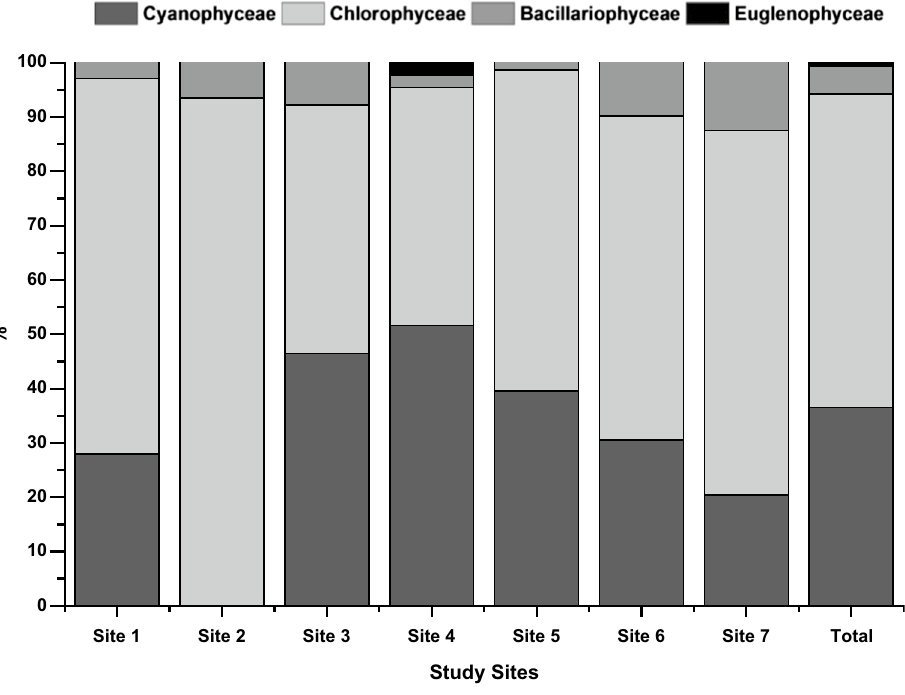
Fig. 2 Percentage distribution of Phytoplankton families in each site and altogether seven sites